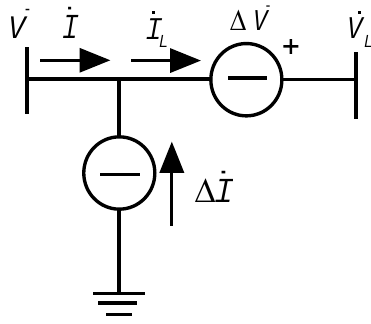
Figure 1. General Flexible AC Transmission System (FACTS) modelling.